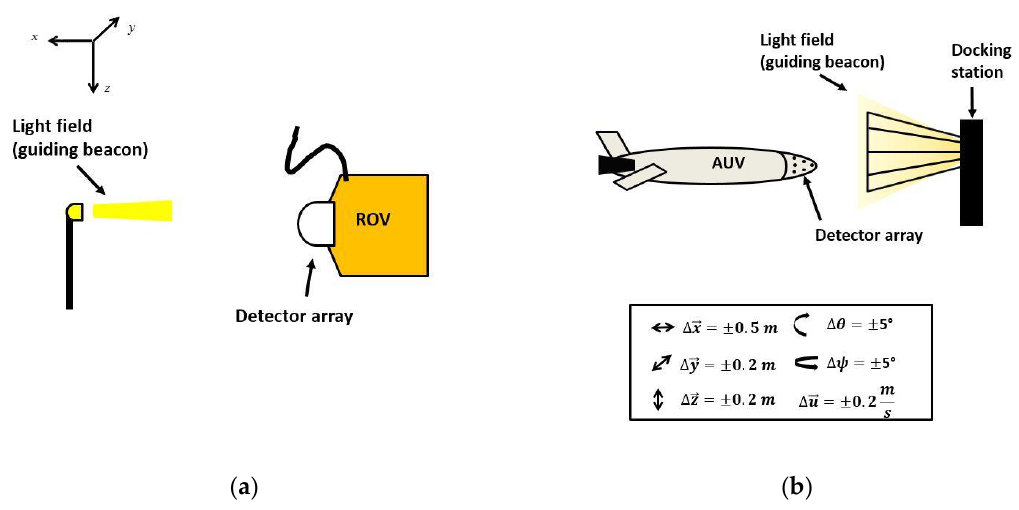
Figure 1. Unmanned Underwater Vehicle (UUV) positioning examples: ( a ) Remotely Operated Vehicle (ROV) dynamic positioning with respect to a light source; and ( b ) Autonomous Underwater Vehicle (AUV) docking station. The light field acts as a guiding beacon with the axis conventions and position and orientation detection parameters used in this study.